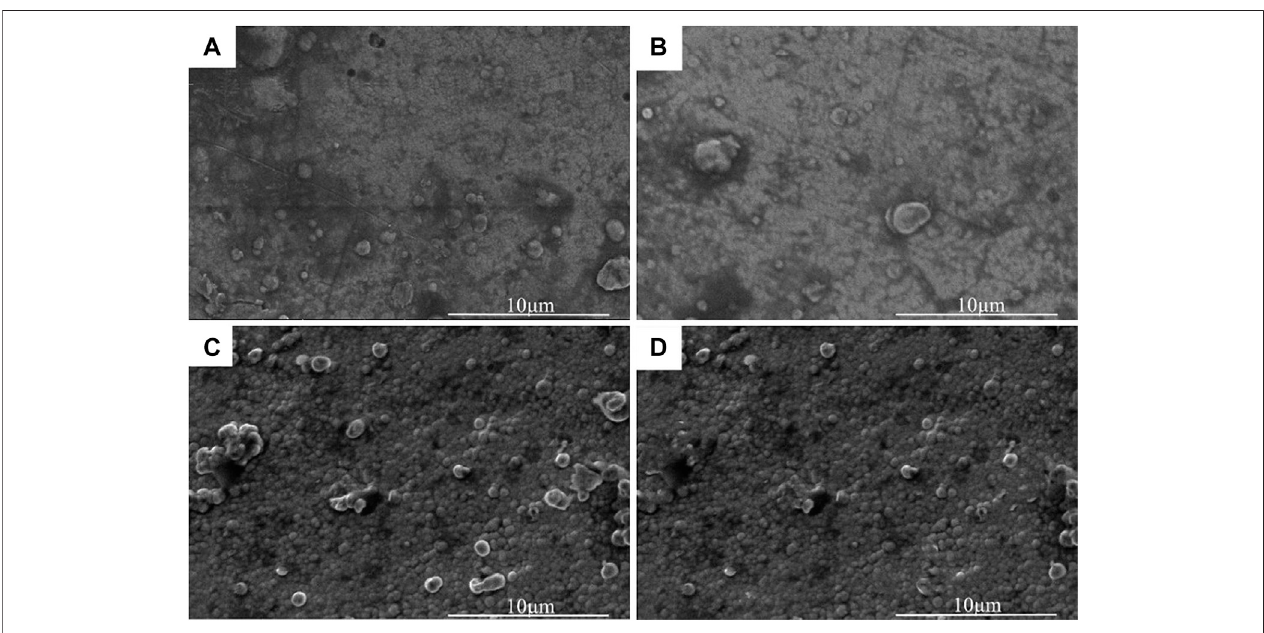
FIGURE 3 | Micromorphology of the nickel-plated layers after 1 h heat treatment at different temperatures: (A) 200 ° C, (B) 250 ° C, (C) 300 ° C, (D) 350 ° C.